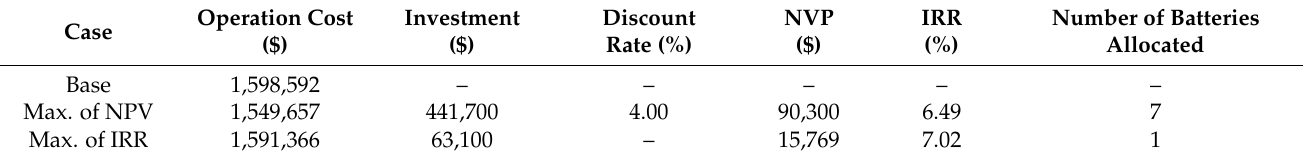
Table 5. Economic information of the alternative solutions found for the optimal battery allocation (OBA) problem.